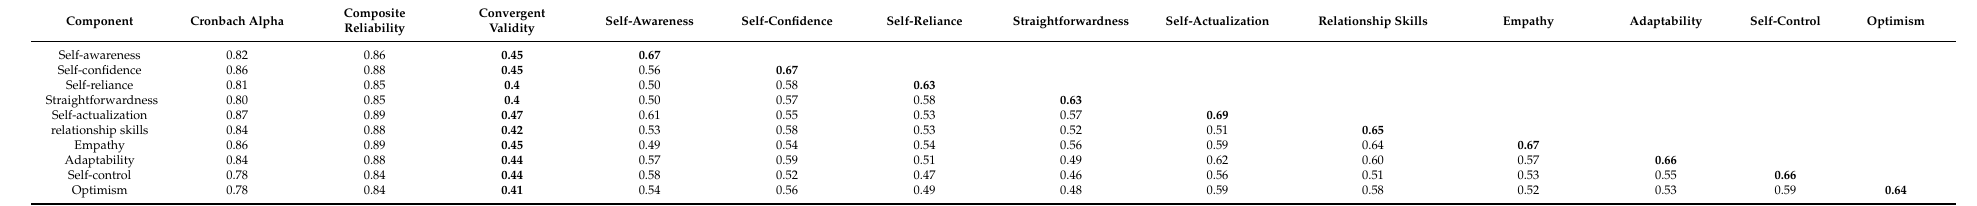
Table 5. Convergent validity coefficients, Cronbach’s Alphas, composite reliability, Fornell and Larker correlation matrix and convergent and discriminant validity. Component CronbachAlpha Composite Reliability Convergent Validity Self-Awareness Self-Confidence Self-Reliance Straightforwardness Self-Actualization RelationshipSkills Empathy Adaptability Self-Control Optimism Self-awareness